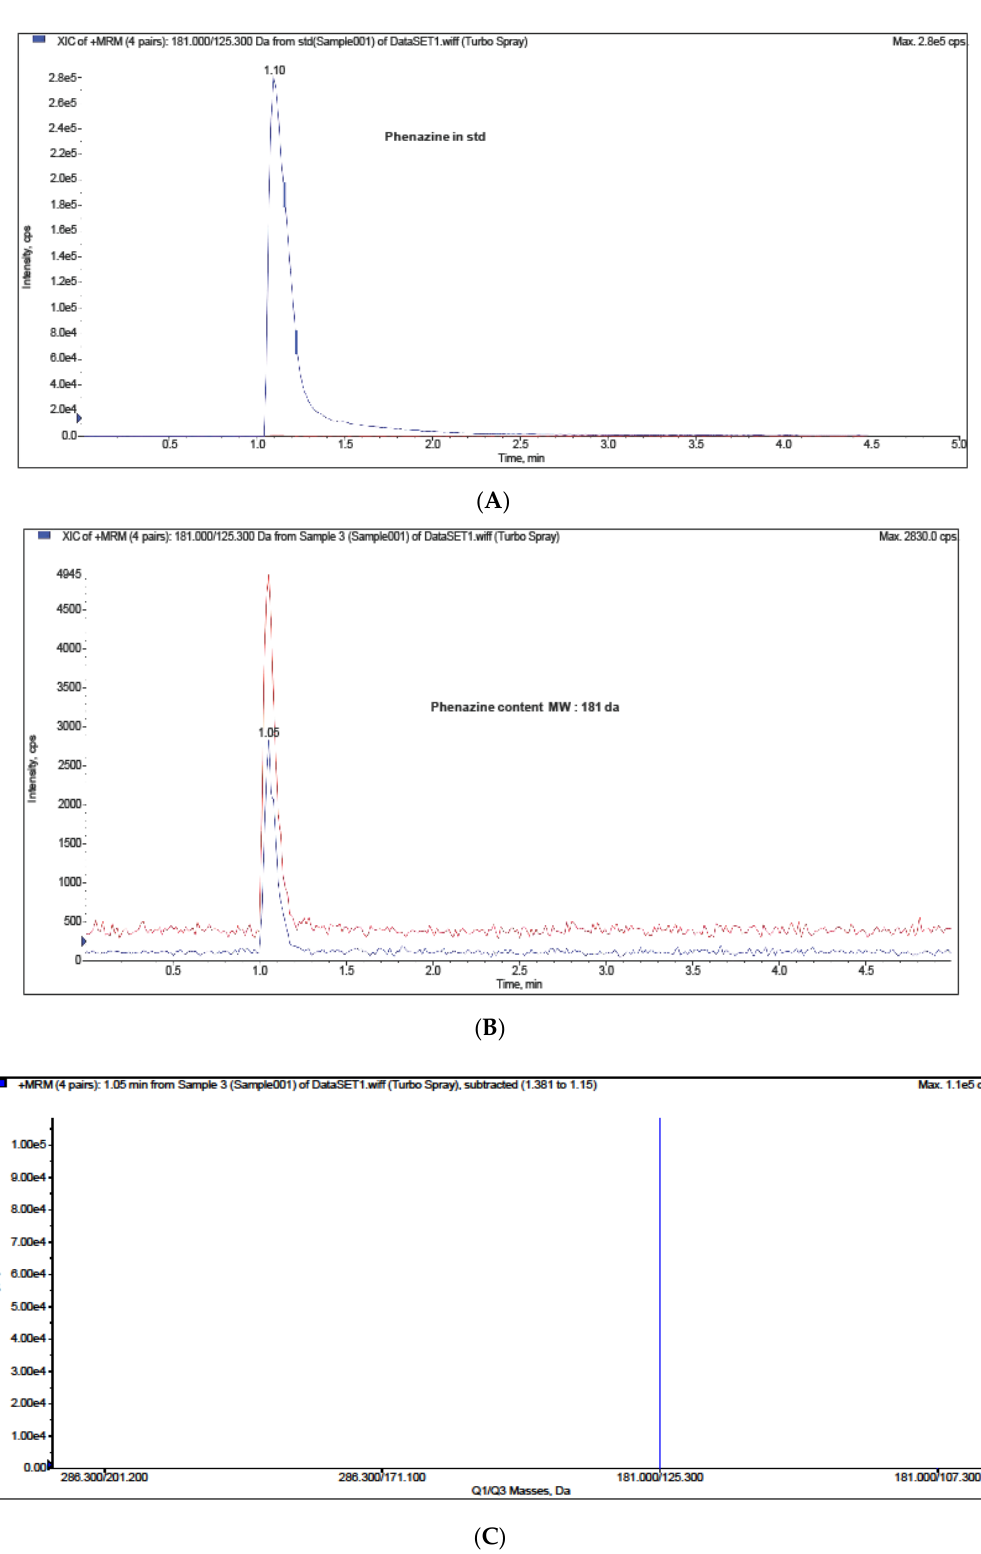
Figure 3. MRM-MS of phenazine-1-carboxylic acid (C 12 H 8 N). ( A ) Standard peak was detected in the retention time of 1.10 min at a wavelength of 248 nm. ( B ) The endophytic fungal valproic acid treated extract also peaked at the retention time of 1.05 min. ( C ) MRM-MS detected that the extract of endophytic fungus contained a mass at 181 kDa (positive mode of ionization). The mass of phenazine-1-carboxylic acid is 180 kDa.